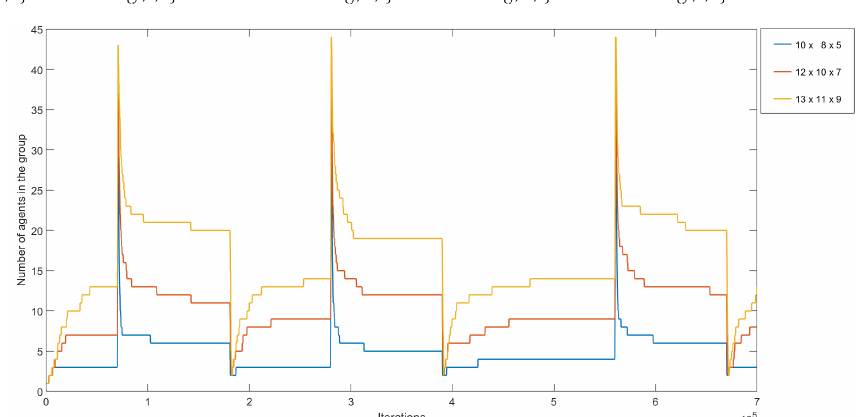
Figure 14. Adaptation of the group’s population in spaces of various sizes, simulated for 700,000 iterations: Pmax { f , k , v } = Pa { f , k , v } = Pr { f , k , v } = 400, TCa { f , k , v } = 0, TRa { f , k , v } = 280, TCr { f , k , v } = 8, TRr { f , k , v } = 100, and Pena { j , m , i } ( t ) = Penr { j , m , i } = 3 ∗ Pmax { f , k , v } , space sizes 10 × 8 × 5, 12 × 10 × 7 and 13 × 11 × 9 cells. We added 30 agents into the group in the 6000th, 27,000th, and 56,000th iteration and the group’s population was reduced to two agents in the 18,000th, 39,000th, and 67,000th